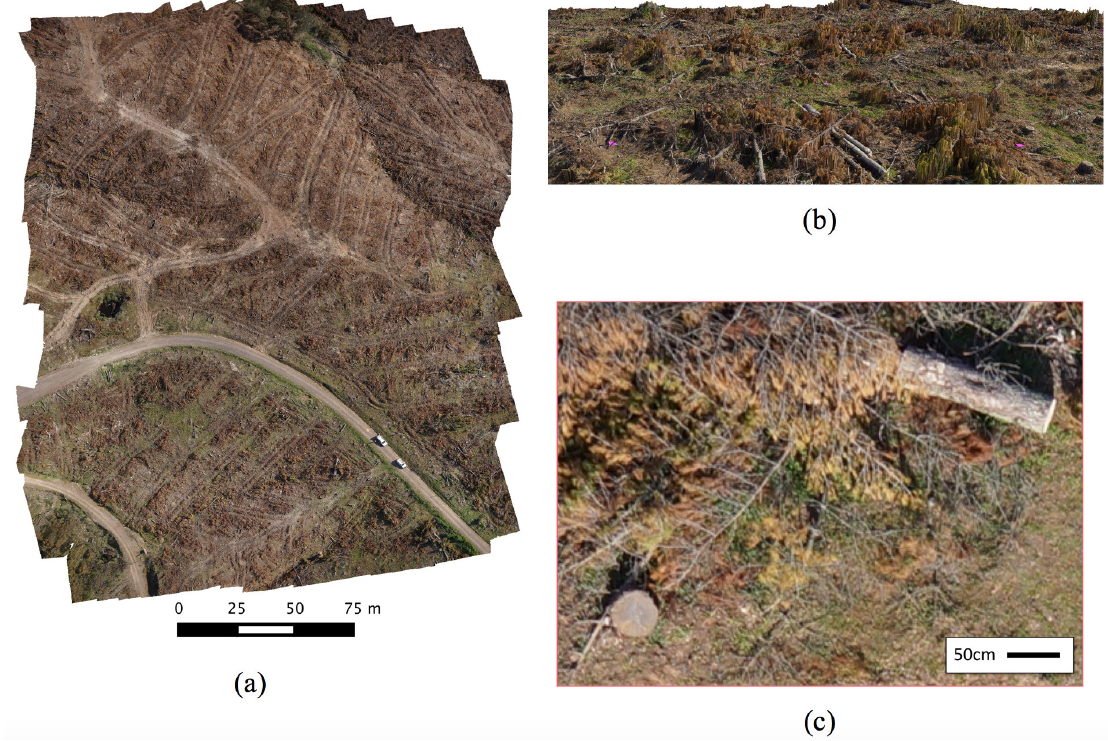
Figure 2. Post-processed high-resolution imagery maps using data collected from a UAV of post-harvest fieldwork sites. ( a ) Imagery mosaic from 30 m altitude UAV flight. ( b ) Oblique view of photo-textured 3D topographic model generated from imagery using structure from motion. ( c ) Zoomed-in view of high-resolution imagery mosaics illustrating detailed